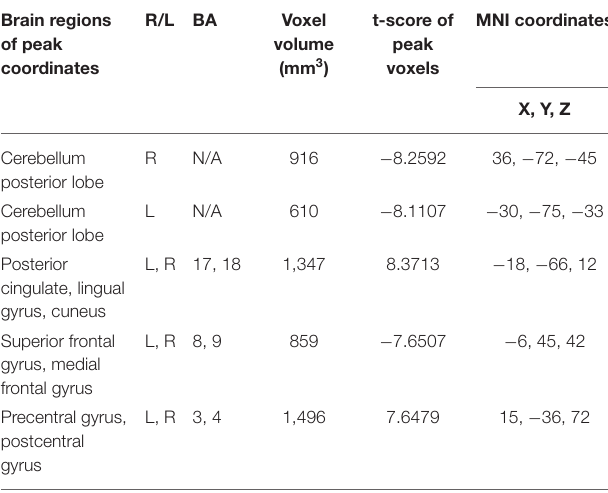
The statistical threshold was set at a corrected significance level of individual two-tailed voxel-wise p < 0.001 using a Gaussian random field corrected threshold of cluster p